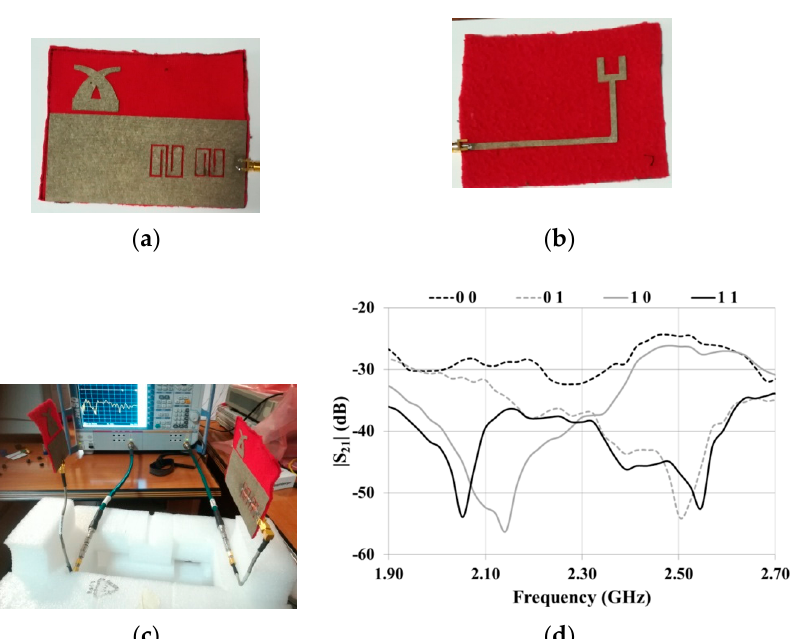
Figure 10. Experimental results achieved for the 2-bit tag. ( a ) Front and ( b ) back view of the stopband microstrip line integrated with the RX antenna; ( c ) experimental setup adopted for measurements; ( d ) measured transmission coefficients for the four configurations of interest.